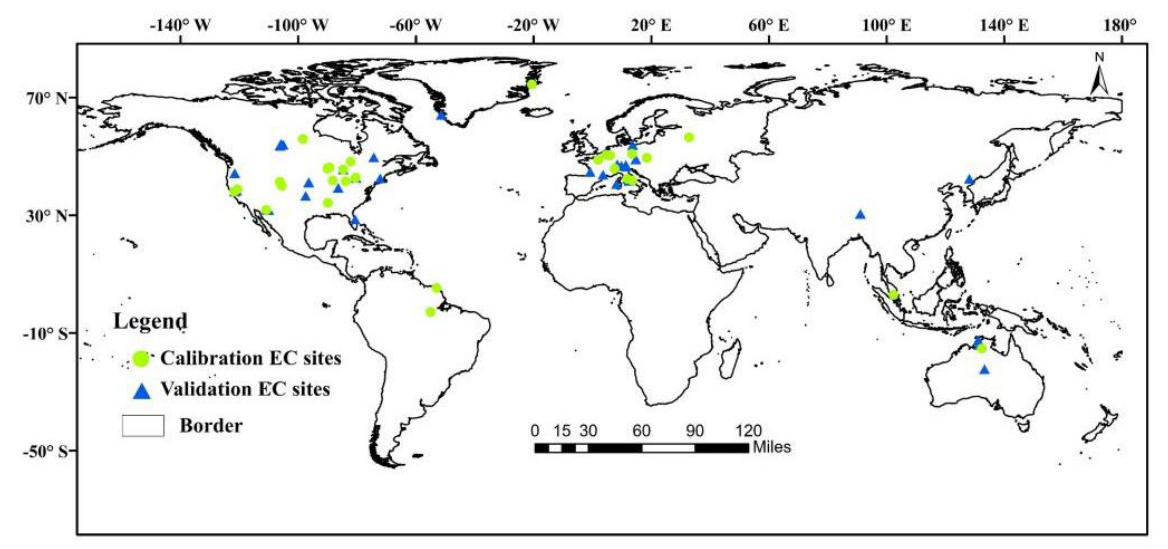
Figure 1. Geographical distribution of the eddy covariance (EC) flux sites used in this study. Green circles stand for sites used for calibration, while blue triangles indicate sites used for validation. The daily GPP variable (GPP_NT_VUT_REF) was estimated using net ecosystem exchange (NEE) methods [38]. The air temperature (Ta), sensible heat (H), and latent heat (LE) variables were quantified for each site. Using marginal distribution sampling (MDS), carbon flux measurement data were gap-filled with LE and H. The daily average values were aggregated to the 8-day time step to match the time step of other